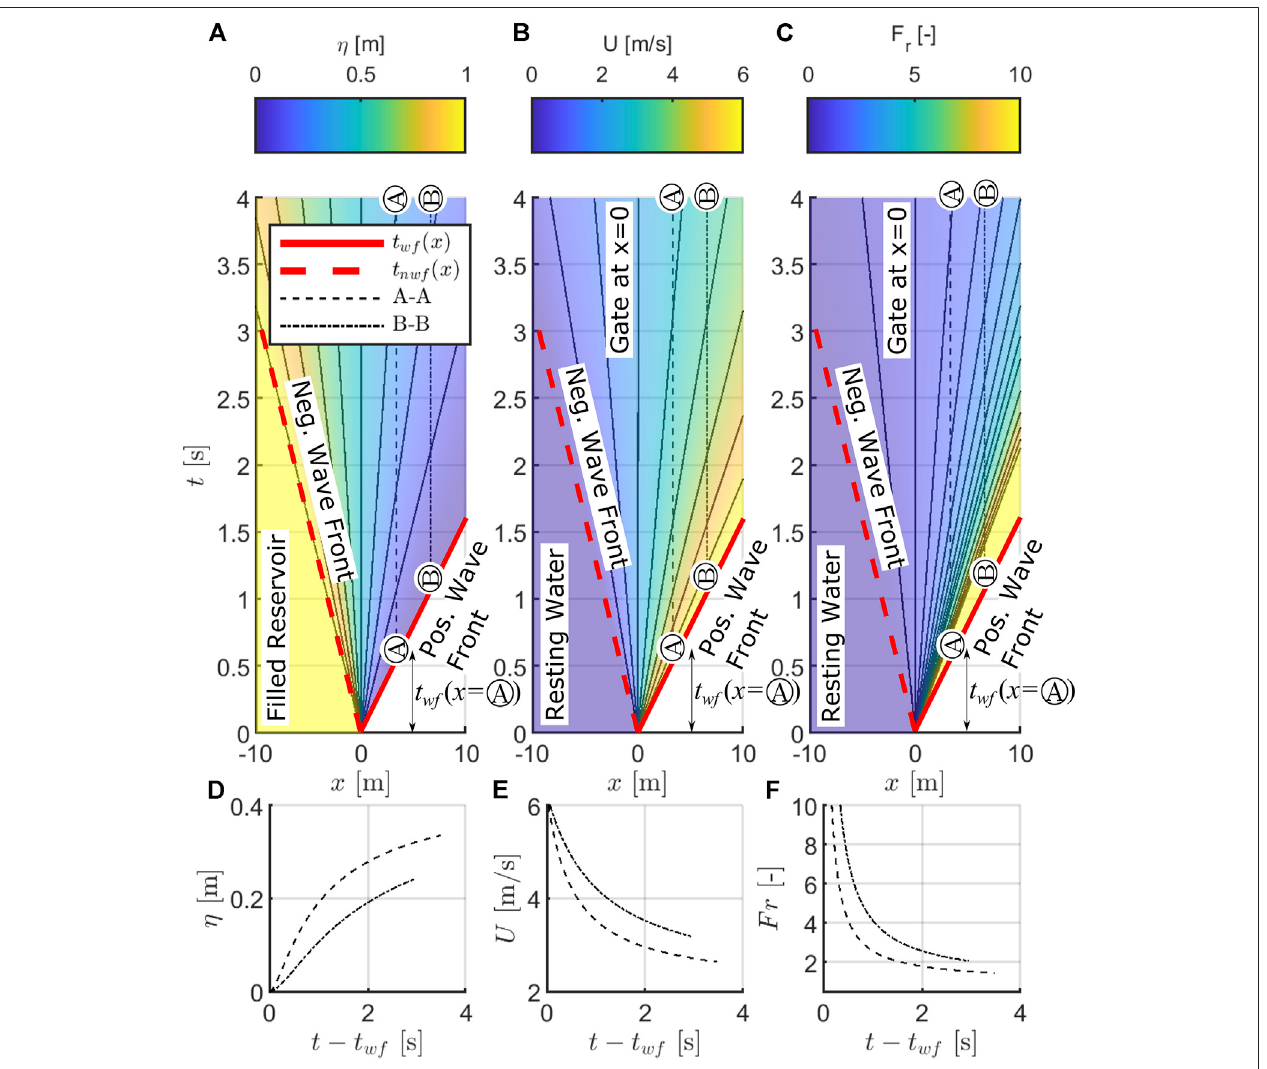
FIGURE6| Flowfeaturesofadam-breakwaveinspaceandtimederivedfromtheanalyticalapproximationbyRitter(1897).Surfaceelevation (A) ,depth-averaged velocity (B) , and Froude number (C) are indicated as colors. Dam-break location at x = 0 m, reservoir spreading in negative x -direction. Dry, frictionless propagation section on positive x -direction. Positive and negative wavefronts are indicated as solid and dashed red lines. These lines also indicate the time when the positive or negativewavereachesaspeci fi cposition( t wf and t nwf ,respectively).Isolinesaredisplayedasthinblacksolidlines.Transectsovertime (A – A,B – B) areindicatedin each sub fi gure (A – C) as dashed lines. Time histories at these transects are displayed in sub fi gures (D – F) .